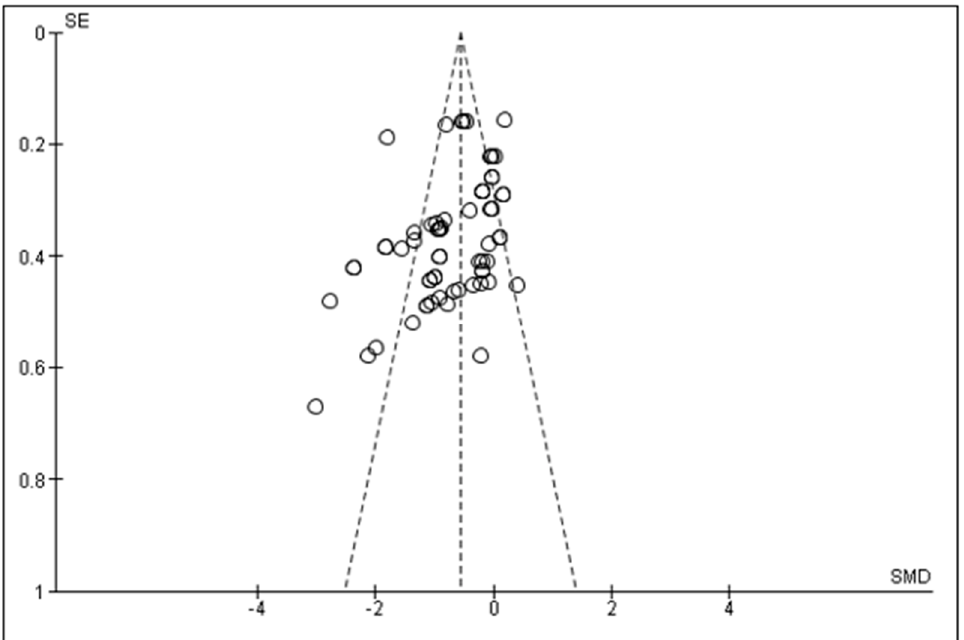
Figure 2. An asymmetrical funnel plot with the publication bias showing the effects of electrical stimulation on Warner–Bratzler shear force (kg) in sheep, lamb, and goats. The gap in the bottom indicates missing smaller studies with no beneficial effects. SMD and SE indicate standardized mean difference and standard error.